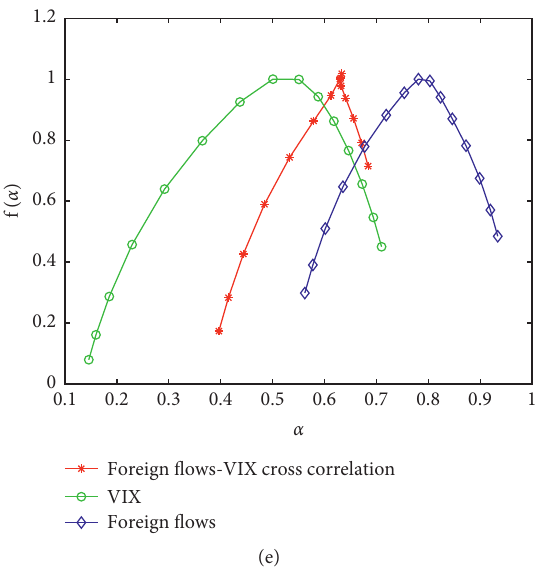
Figure 11: Cross-correlation analysis and MF-DCCA analysis between the foreign flows after the implementation of Shenzhen-Hong Kong Stock Connect and VIX index. (a) Cross-correlation statistics Q cc ( m ) . (b) Log-log plots of F q ( s ) versus s . (c) Generalized Hurst exponent of H ( q ) versus q . (d) Renyi exponent of τ ( q ) versus q . (e) Multifractal spectrum f ( α ) versus α